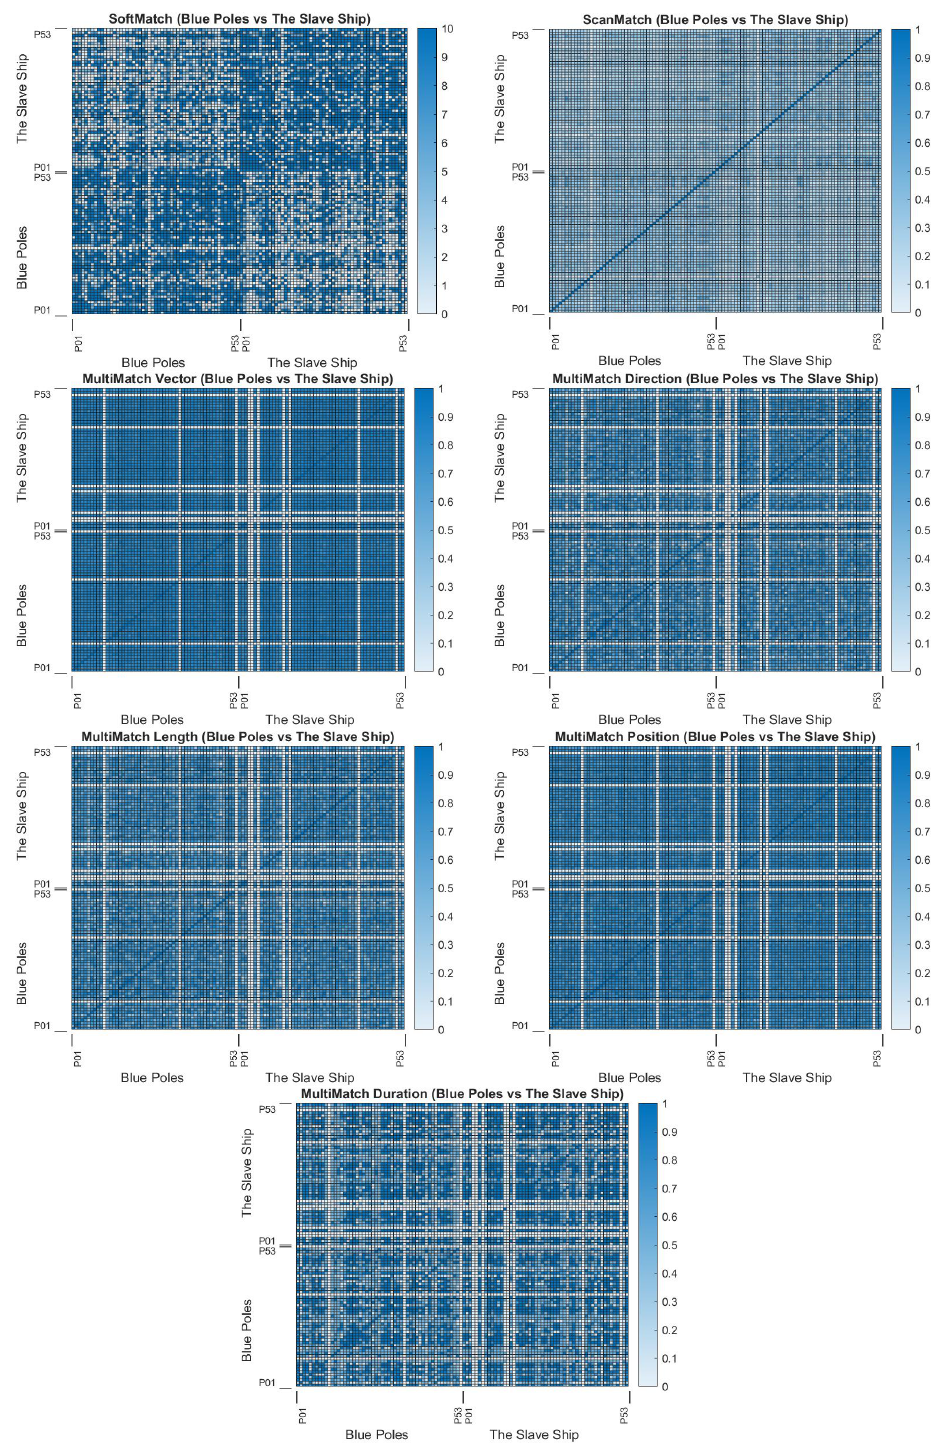
Figure A5. SoftMatch, ScanMatch, and MultiMatch heatmaps for empirical evaluation. Stimuli matched are Jackson Pollock’s Blue Poles (1952) and William Turner’s The Slave Ship